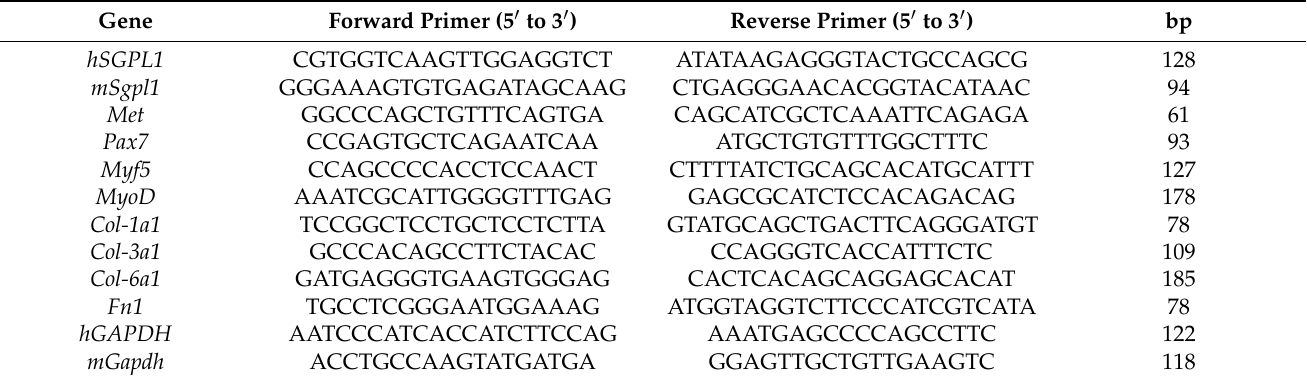
Table 5. Primer sequences used for